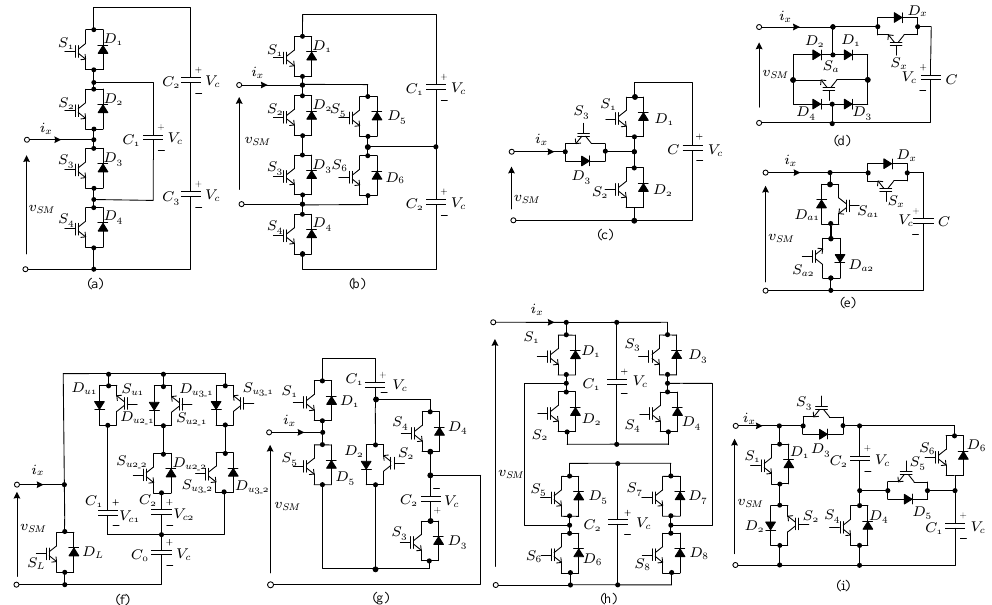
Figure 4. Unipolar SMs: ( a ) FC-SM—Flying capacitor SM; ( b ) M-ANPC-SM—Modified active neutral-point clamped unipolar SM; ( c ) SS-SM—Series switch SM; ( d ) BBSM1—Bidirectional blocking SM 1; ( e ) BBSM2—Bidirectional blocking SM 2; ( f ) SSwC-SM—Stacked switched capacitor SM; ( g ) 3L-SwCSM—Three-level switched-capacitor SM; ( h ) 3L-DSM—Three-level double SM; and ( i ) FTSM— Fault tolerant